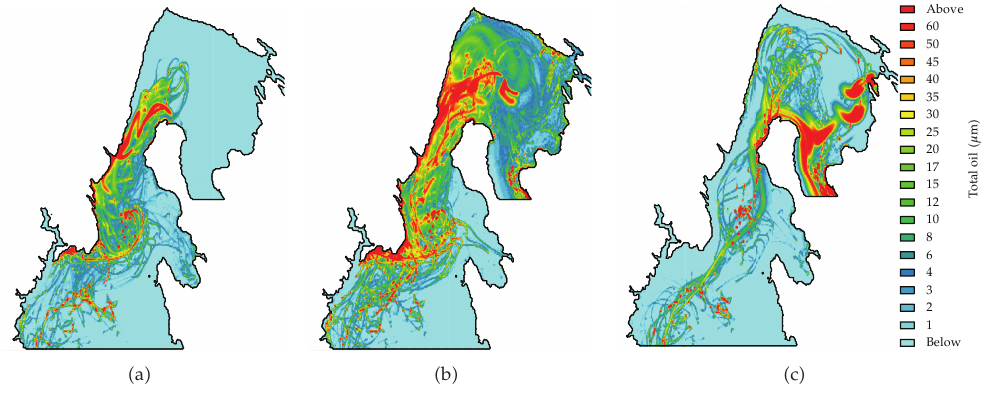
Figure 15: Fields of oil thickness with maximum simulated values for all numerical cells in the surface layer during the entire summer period 21/7/08–31/7/08 (cid:4)(cid:4) a (cid:5) oil spill released at the position 1; (cid:4) b (cid:5) at the position 2; (cid:4) c (cid:5) at the position 3 (cid:5)